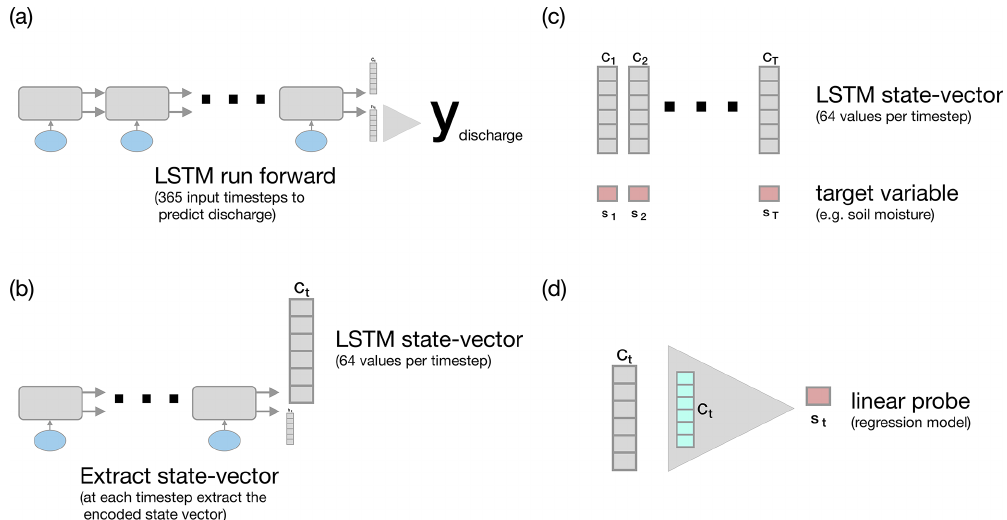
Figure 1. An overview of the linear probe analysis. Panel (a) demonstrates the LSTM as an input–state–output model, where at each timestep, inputs (blue spheres, such as precipitation) are processed, producing a prediction of discharge on the 365th day. This reflects how the LSTM is trained. (b) When forcing the model with already trained weights, we extract the LSTM state vector ( c t ) at each timestep. (c) We then compile a dataset of inputs (the c t vectors for each target timestep) and targets ( s t – the soil moisture measurements for the catchment) matched at each catchment and timestep. (d) Finally, we use this dataset to train a linear probe, a set of weights, and a bias term for all